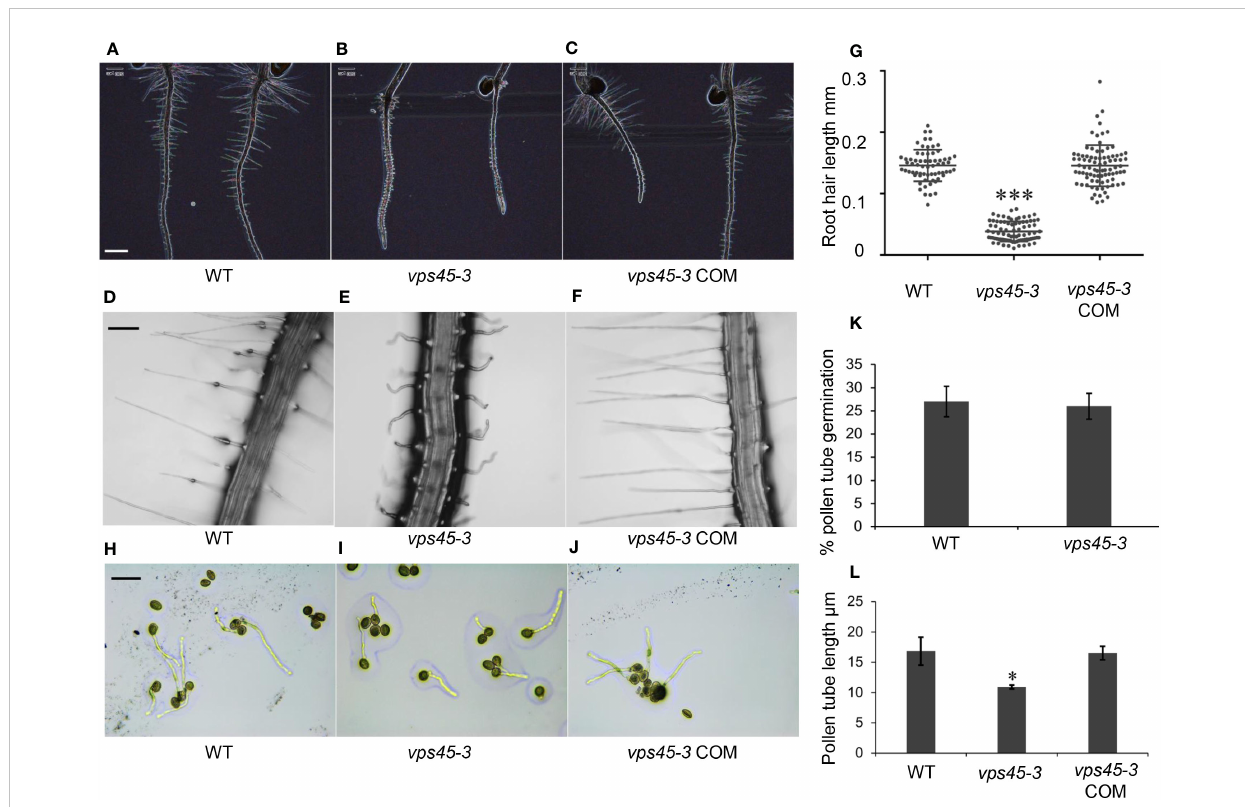
FIGURE 3 vps45-3 has root hair and pollen tube defects. (A – C) Color inverted images of 5-day-old roots of WT, vps45-3 and vps45-3 COM to show root hair silhouettes. Scale bar = 500 m m. (D – F) Representative light microscopic images of 7-day old WT, vps45-3 and vps45-3 COM root hairs. Scale bar = 50 m m. (G) Root hair length of 7-day old WT, n= 66, vps45-3 , n= 83 and vps45-3 COM, n = 86 seedlings. Data are measurements of each individual root hair. Error bars show standard deviations, * shows statistically signi fi cant differences (P < 0.05), determined by one-way ANOVA. (H – J) Pollen grains from WT, vps45-3 and vps45-3 COM plants were germinated on medium overnight and examined under a light microscope. Scale bar = 50 m m (K) Percentage pollen germination comparison for WT and vps45-3 . (L) Average pollen tube length comparison for WT,